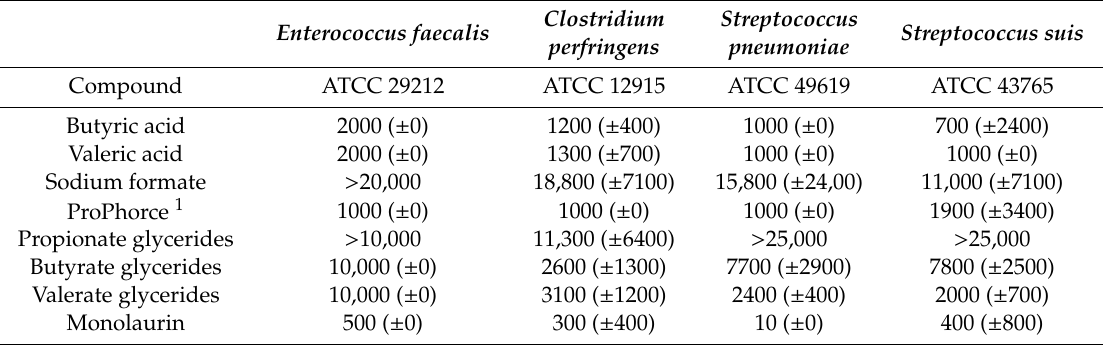
Table 4. Minimum inhibitory concentrations (mg / L) ( ± SD) of organic acids and their derivatives on tested Gram-positive (G + ) bacteria strains.